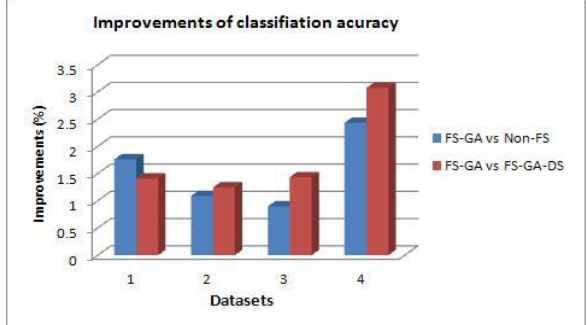
Figure 7. Improvements of overall classification accuracy